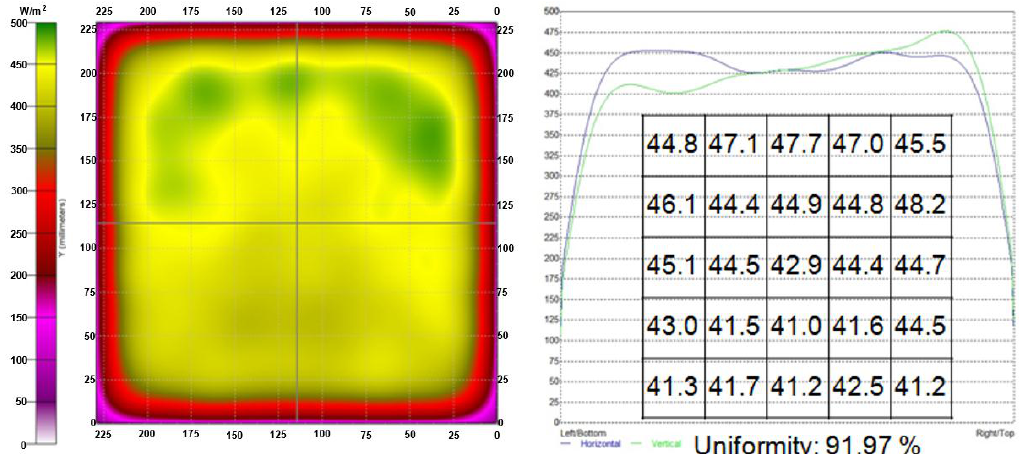
Figure 24. Simulation results of LED power adjustment type 1.